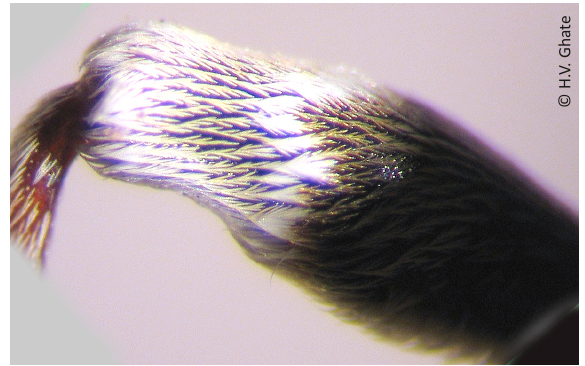
Image 9. Femur of Apiocephalus showing terminal ring of silky pubescence.